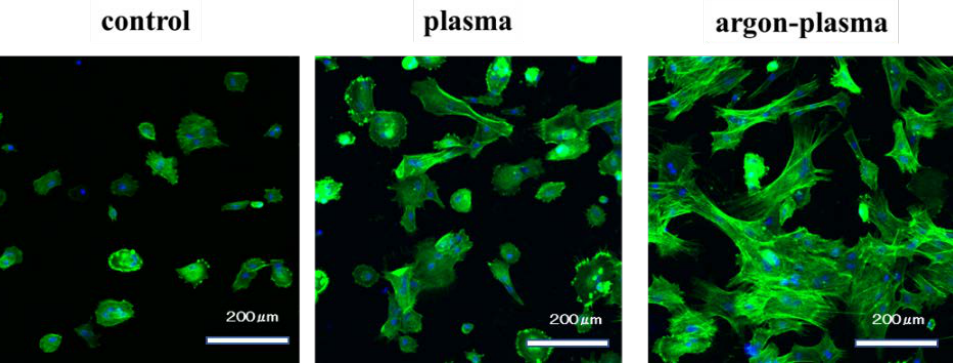
Figure 4. The morphology of RBMCs on the titanium surface after 6 h of culture was observed using a fluorescence microscope. It was confirmed that the RBMCs adhered to the surface of the materials for all three groups.